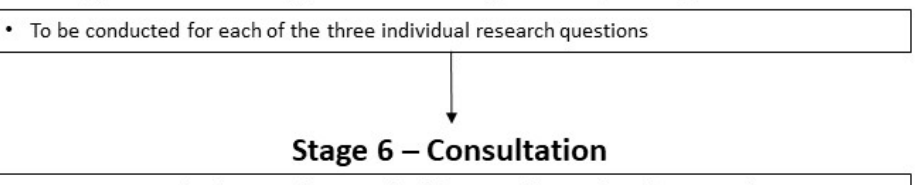
Figure 1. Flowchart of the protocol for this scoping review. Adapted using information from the published protocol [27]. [ICIs, immune checkpoint inhibitors; PPI, patient and public involvement; QoL, quality of life] .